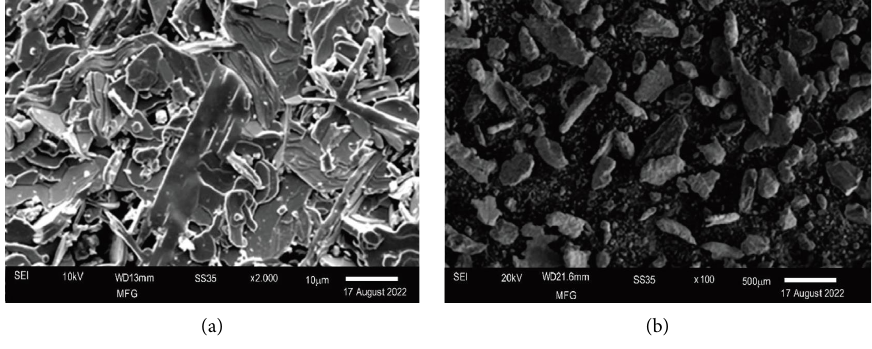
Figure 2: SEM images of (a) MgO and (b)